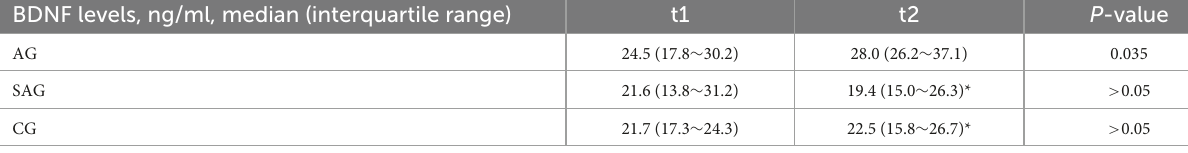
TABLE 3 BDNF levels before and after intervention.